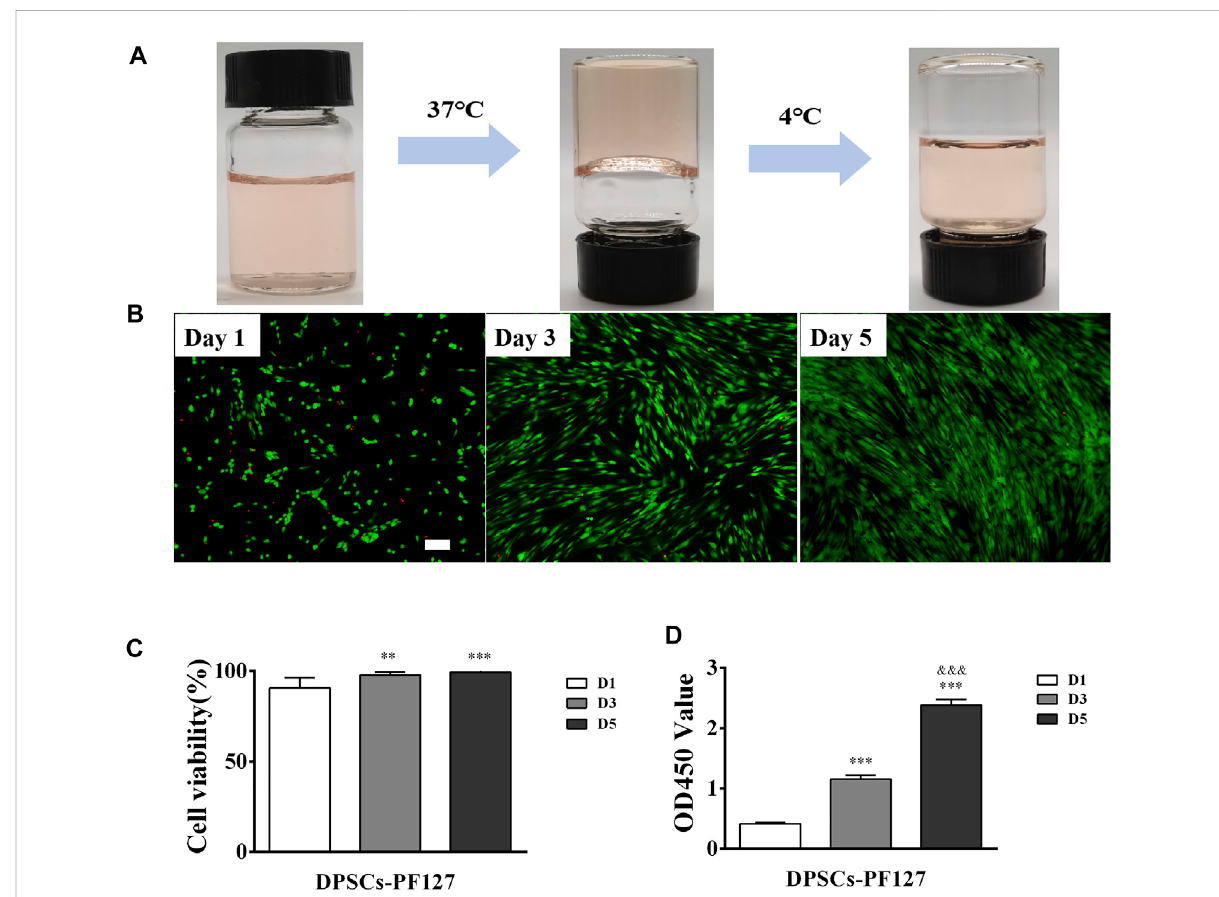
FIGURE 4 The biocompatibility of PF127 hydrogel. (A) The thermosensitive property of PF127. (B) The images of Dead/Live assay of DPSCs encapsulated into the PF127 hydrogel after 1, 3 and 5 days, Scale bar: 200 μ m. (C) Statistical analysis of the cell viability. The ratio of green to green plus red cells provided the percentage of cell viability. ** p < .01, *** p < .001 versus the Day 1. (D) The proliferation activity of DPSCs encapsulated into the PF127 hydrogel after 1, 3 and 5 days were measured using Cell Counting Kit-8. *** p < .001 versus the Day 1, &&& p < .001 versus the Day